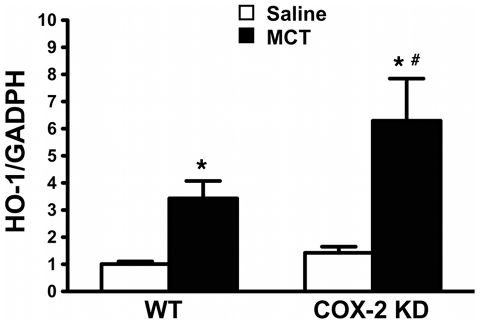
HO-1 mRNA is induced in response to MCT.HO-1 mRNA expression detected by quantitative RT-PCR in whole lung extracts. GADPH was used as endogenous control. Results were calculated as fold-change relative to reference cDNA, as described in Methods and expressed as fold-change relative to WT/saline. WT/saline, n = 6; WT/MCT, n = 10; COX-2 KD/saline, n = 6; COX-2 KD/MCT, n = 6. * p<0.05 vs saline; #, p<0.05 vs MCT-treated WT.